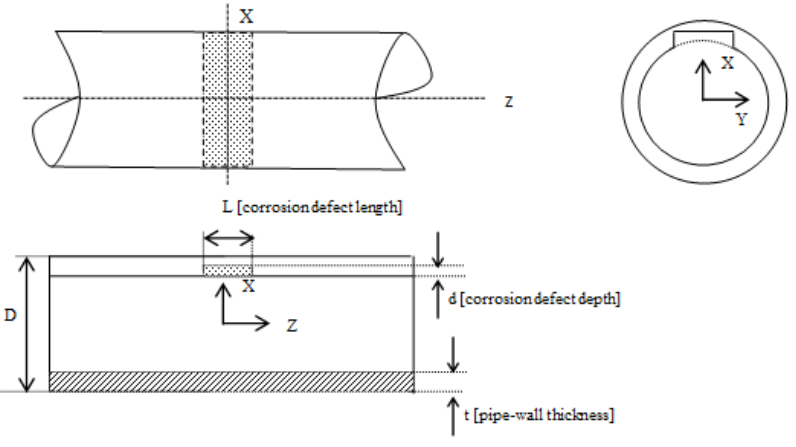
Figure 1. Schematic of a circumferential corrosion defect of a pipe.